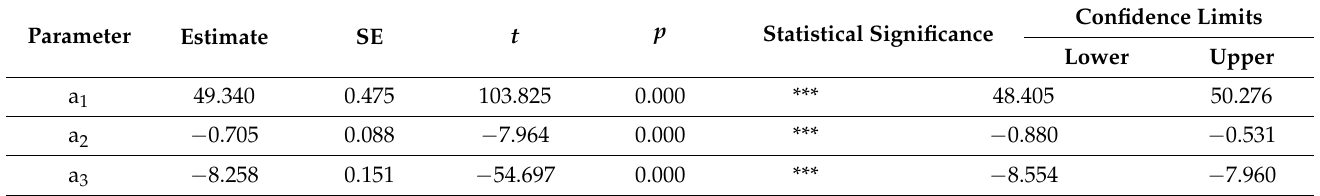
Table 6. Parameter estimates and overall characteristics of the model given by Equation